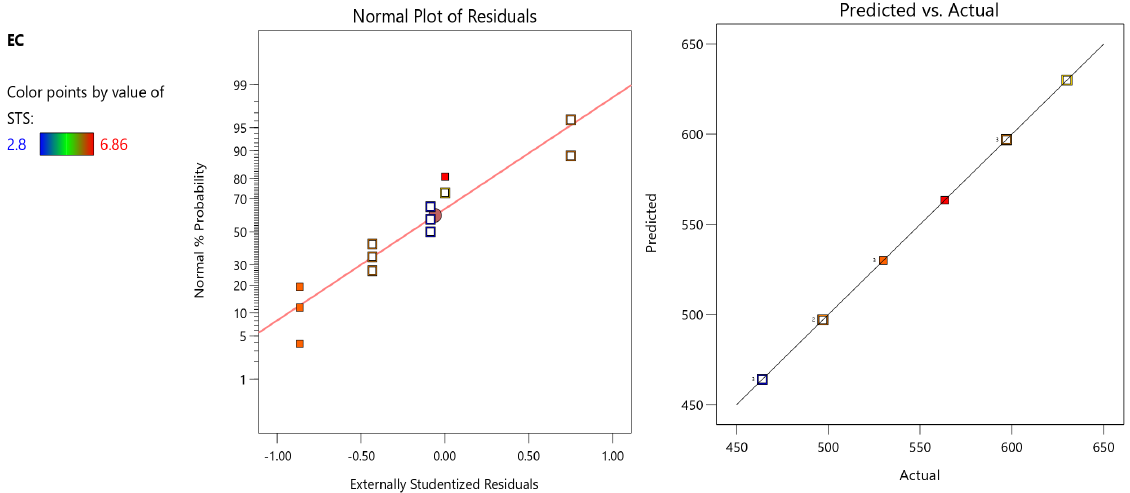
Figure 19. Normal plot for residuals, and actual vs. predicted values for embodied carbon.